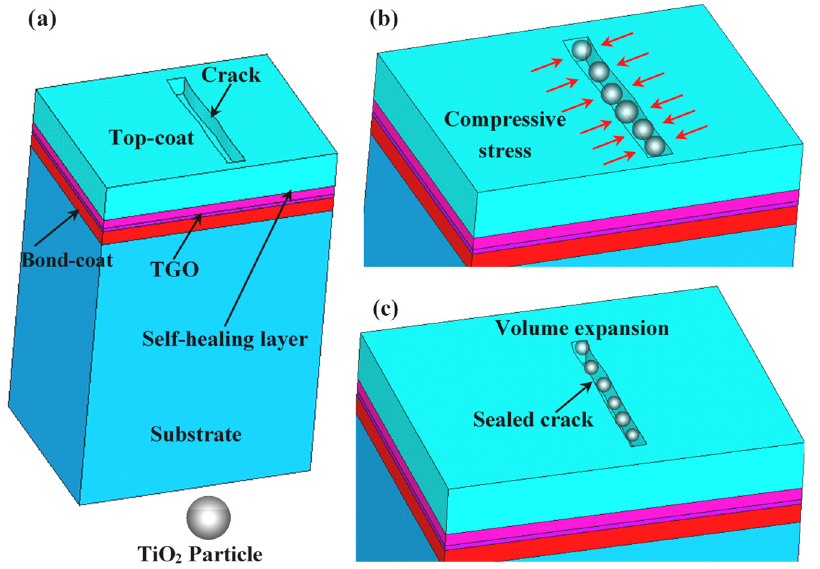
Figure 9. Schematic of the self-healing mechanism for TBCs with a 3D model [69]. ( a ) The presence of the crack; ( b ) the crack filling with TiO2 particle; ( c ) the volume-expansion-induced self-healing phenomenon.